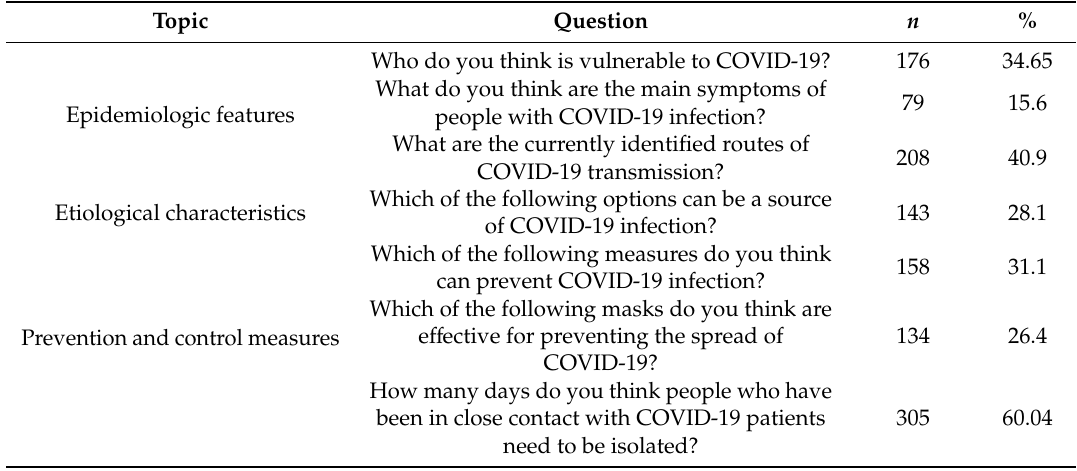
Table 2. Descriptive statistics for the understanding level of the elderly participants.